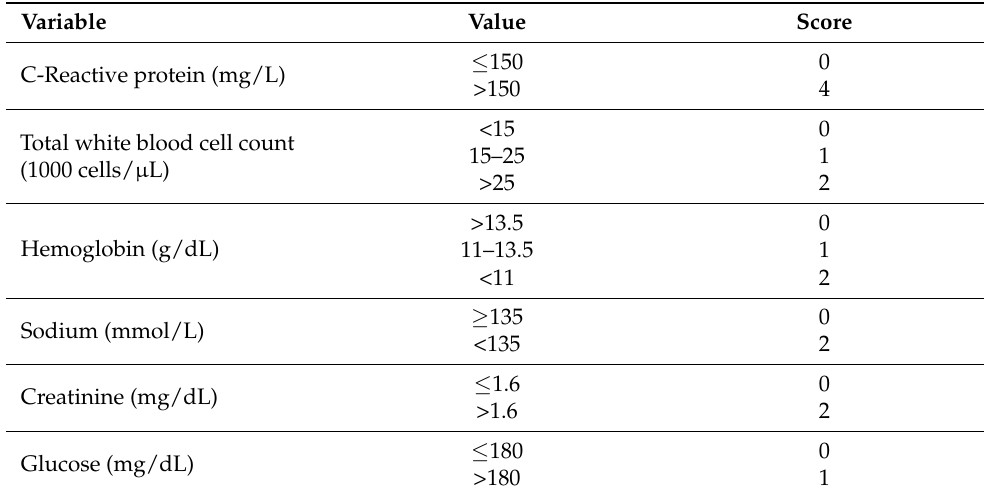
Table 1. The laboratory risk indicator for necrotizing fasciitis score (based on [14]). Variable